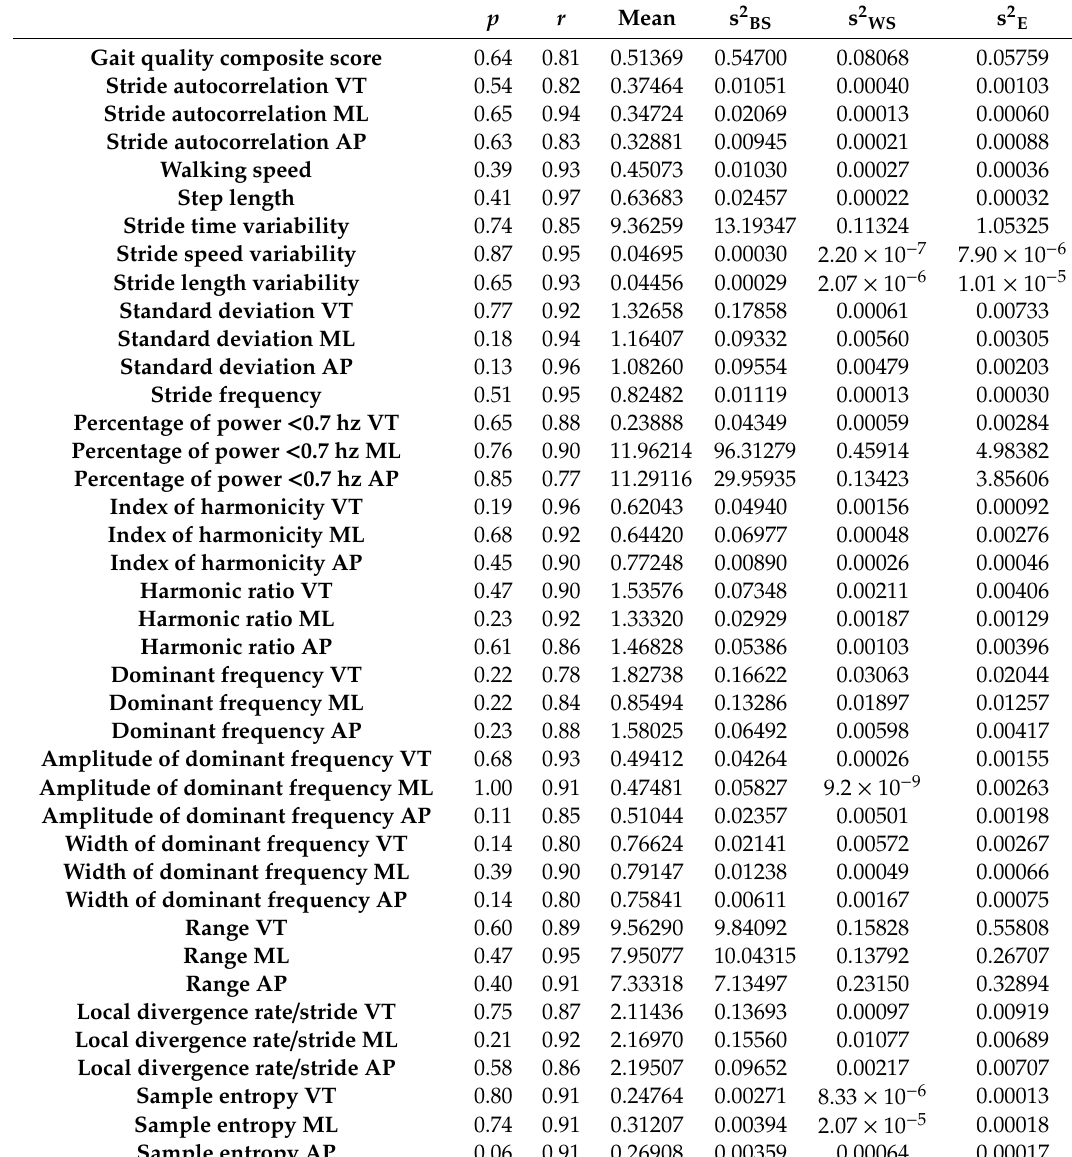
Table A1. Agreement between weeks and estimated variance components for all gait